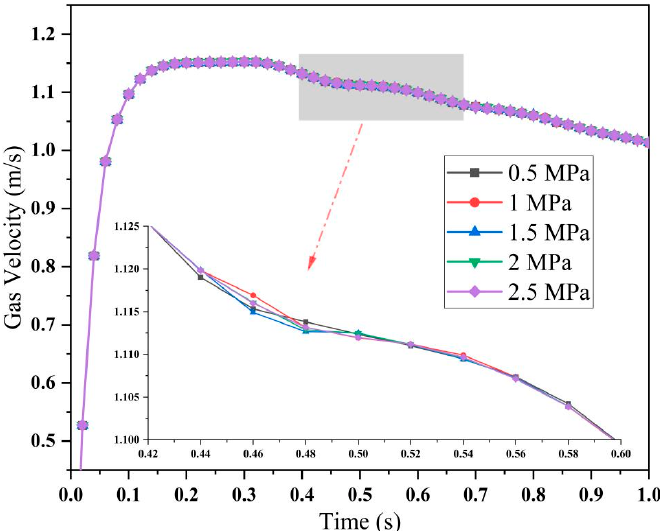
Figure 11. Velocity of a point in the fracture under different pressures.